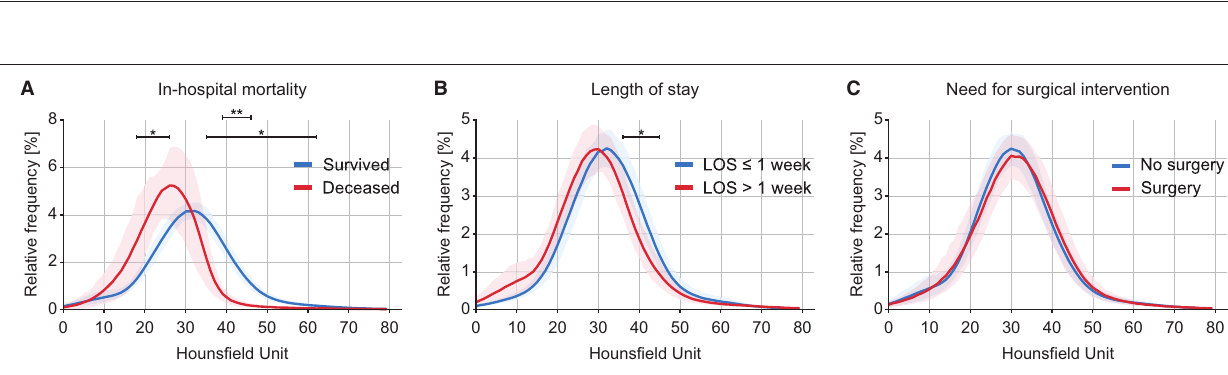
Frontiers in Pediatrics |